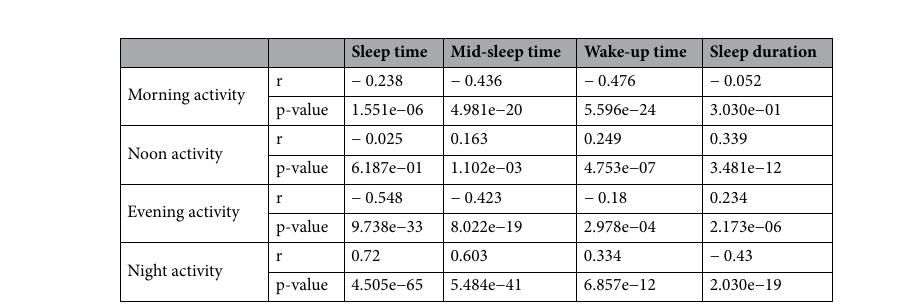
Table 1. Pearson correlation coefficients for the four NMF components and sleep and activity parameters: sleep time, wake-up time, mid-sleep time, and sleep